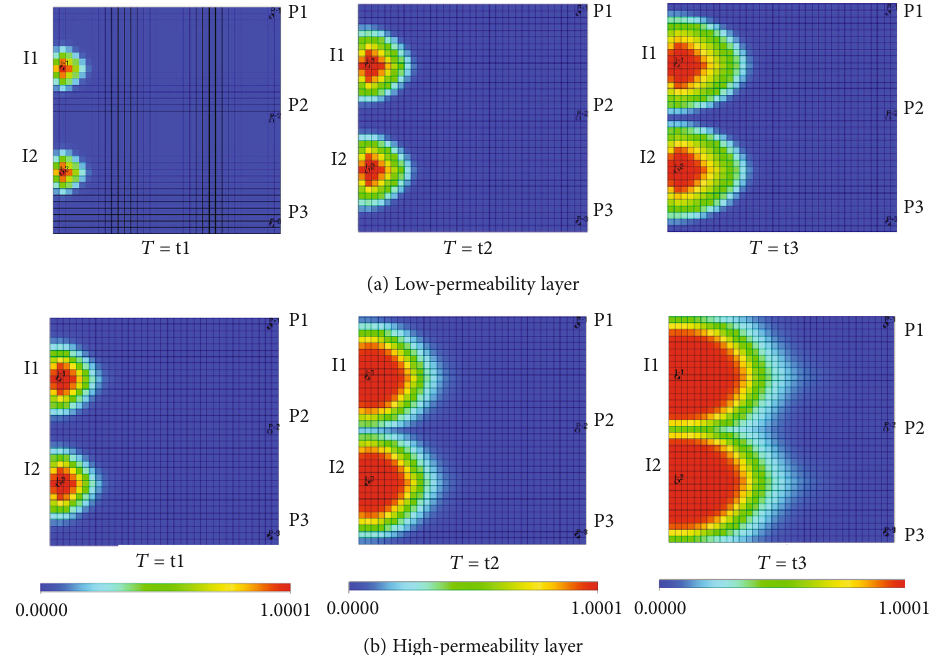
Figure 5: Distribution of injected fl uid at di ff erent time in pure polymer fl ooding.